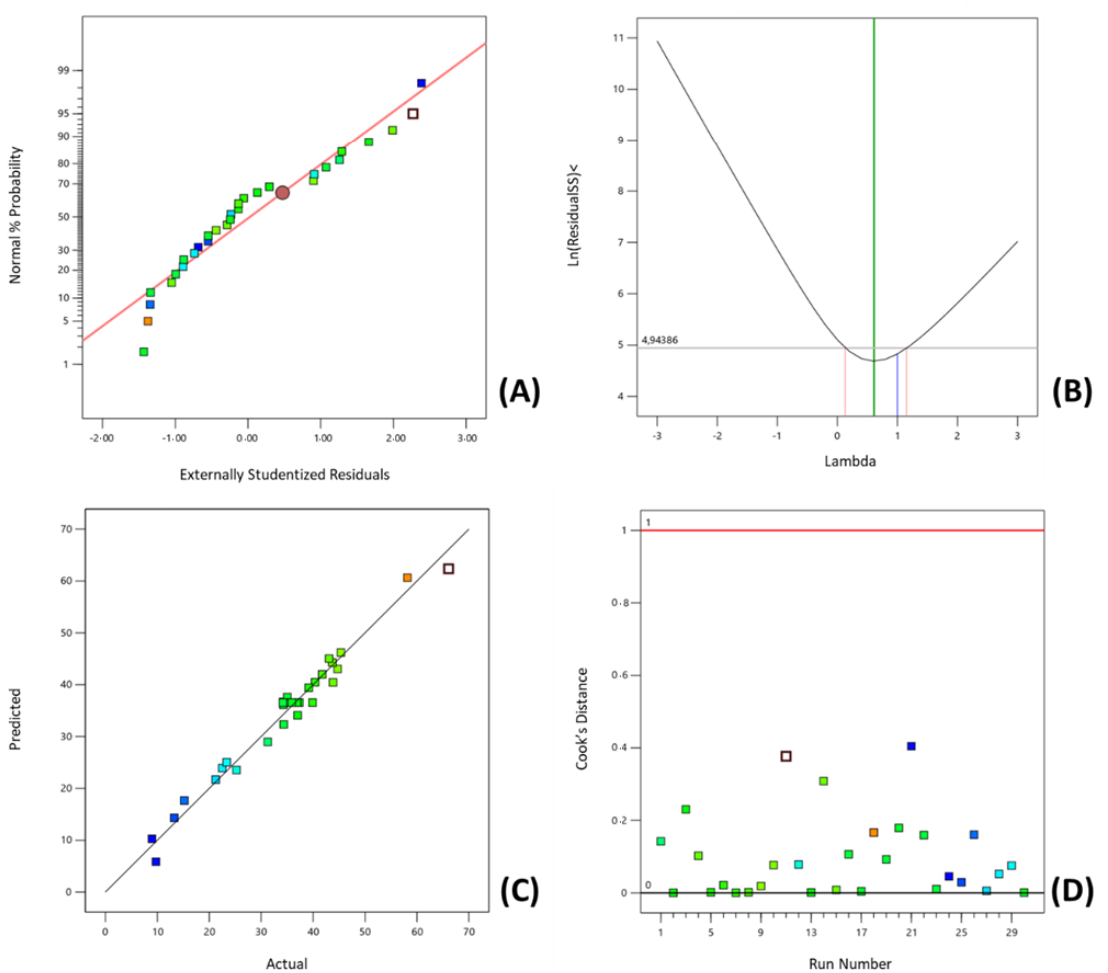
Figure 1. Diagnostic plots for the quadratic model adequacy to the total phenolic content of olive mil pomace extracts (( A )—Normal probability plot; ( B )—Box-Cox plot for power transforms; ( C )—Predicted versus Actual plot; ( D )—Cook’s Distance plot).